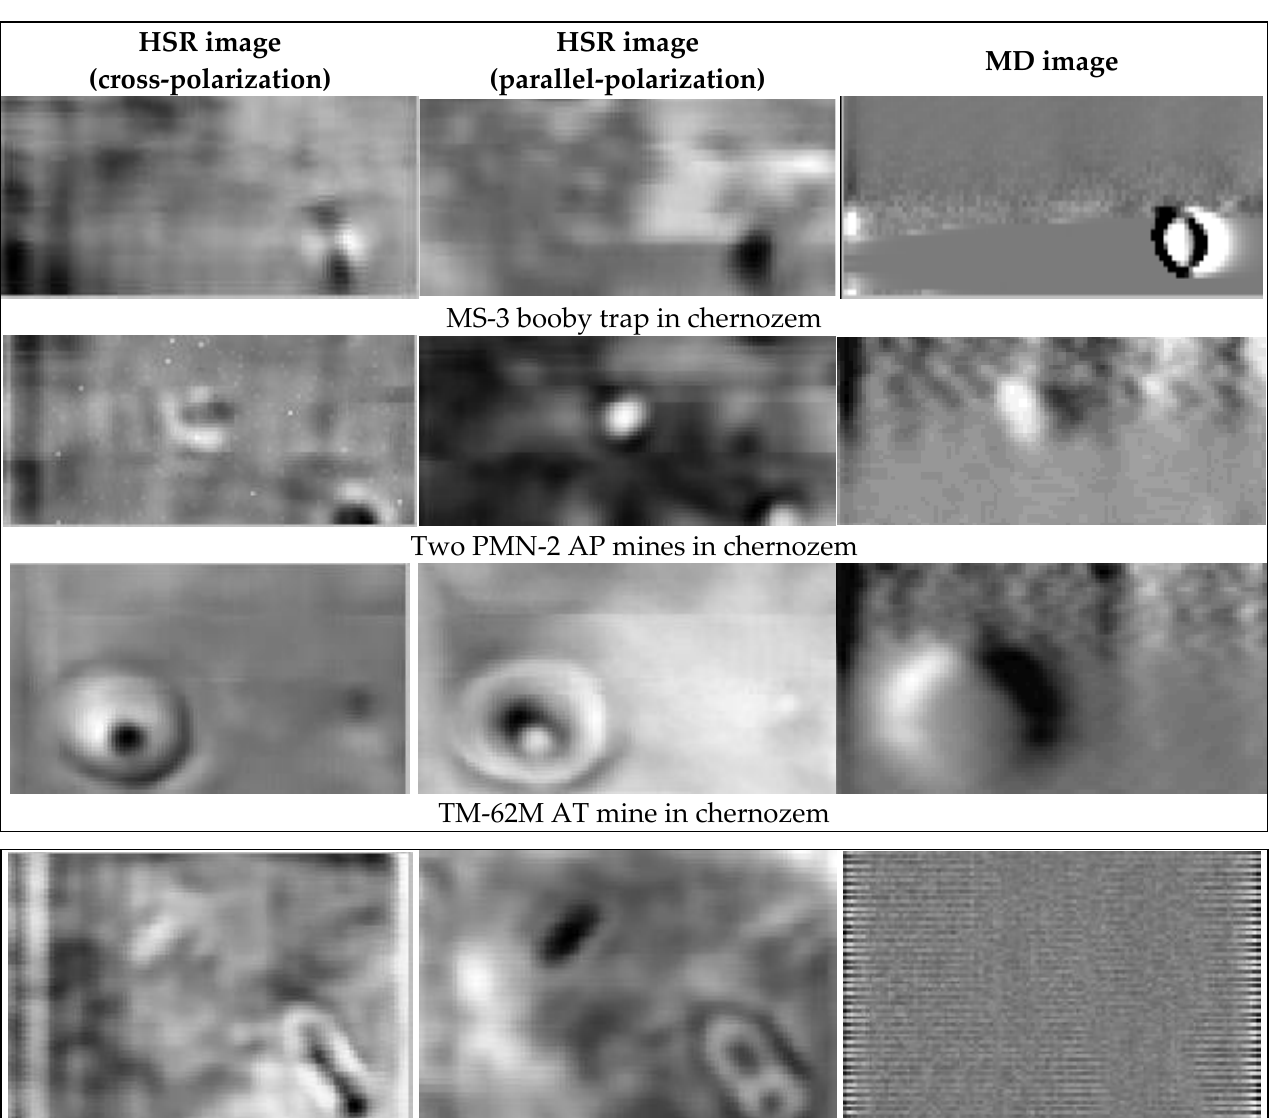
15 of 38 Figure 15. Mines used in experiments: (1) TC-6.1, (2) TC-2.5, (3) TM-62M, (4) TM-62PZ, (5) PTM-3, (6) MS-3, and (7) PMN-2. Since many mine fields are in populated areas and/or former conflict zones, human debris and shrapnel (clutter) produce false alarms that greatly outnumber actual explo- sive threats. To test discrimination between mines and clutter, glass and plastic bottles (empty and filled with water) were buried in the test bed. The AT mines and bottles were laid in the ground at a depth of 5 cm to 10 cm and the AP mines at a depth of 1 cm to 5